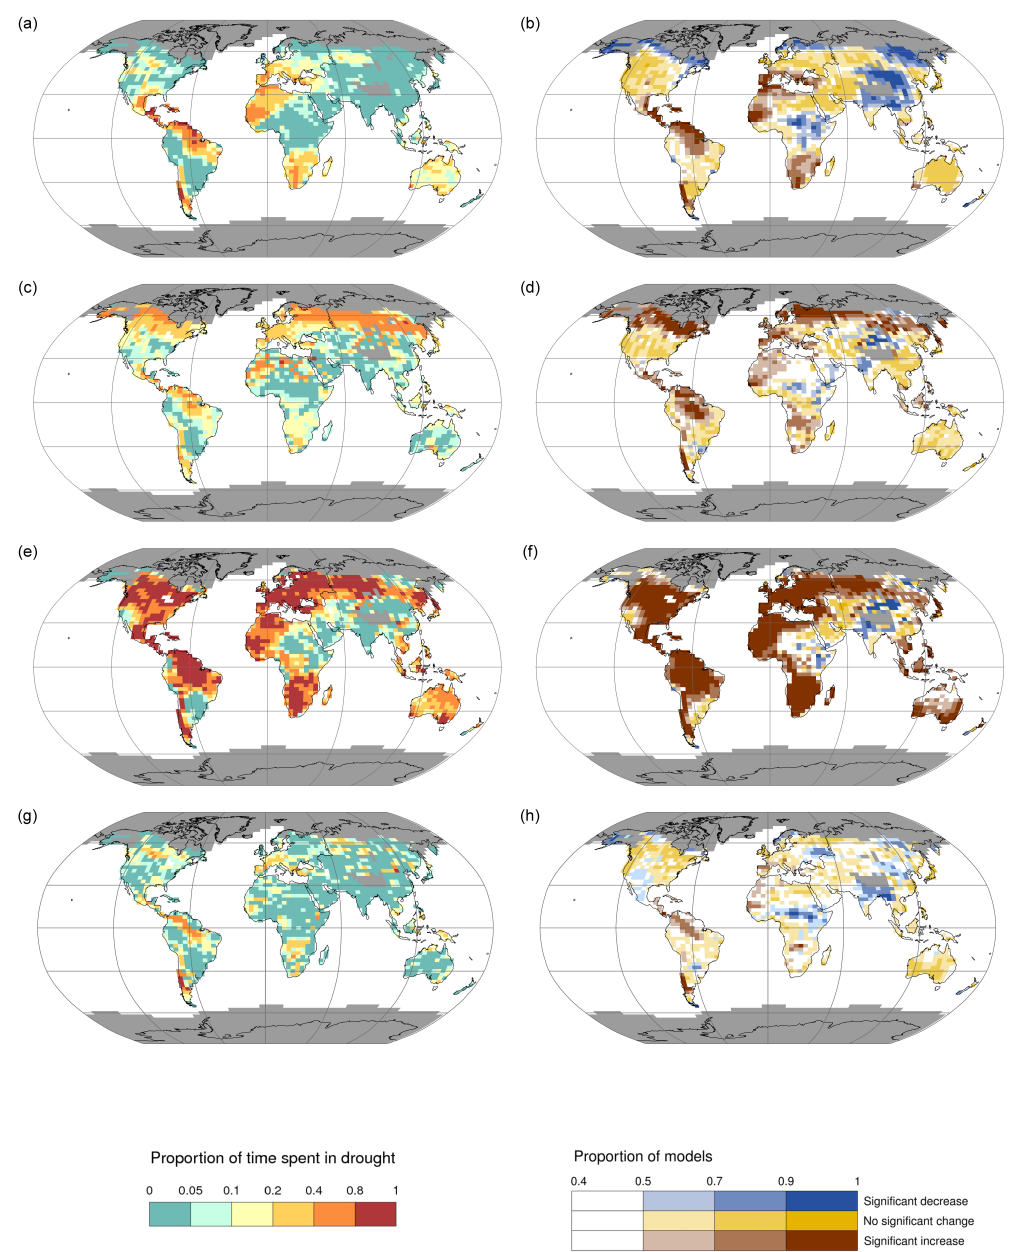
Fig. 5. The proportion of time spent in drought for three drought indices from the ESE for the A1B future scenario in the 2080s (2070–2099), exemplar model (left) and model agreement of significant changes (right). (a) and (b) are the SPI, (c) and (d) are for the SMA; (e) and (f) are for the PDSI; and (g) and (h) are for the SRI. Grey areas represent the excluded cold regions. Results shown are for the 10th percentile calculations